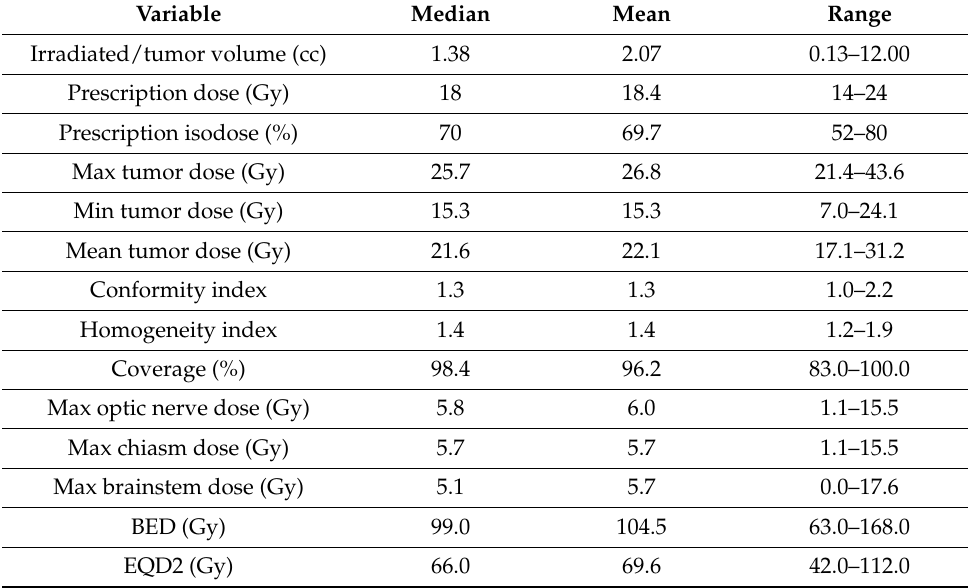
Table 2. Treatment